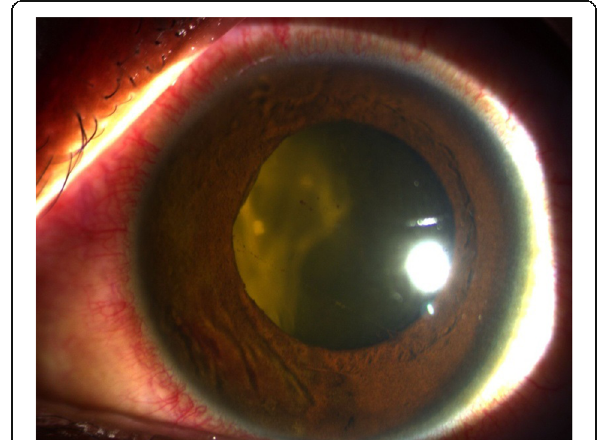
Fig. 4 On day 15 post-laser, seen are beginning nasal papillary synechiae, retrolental membranes, decreased anterior chamber reaction, homogeneous gray haze on indirect ophthalmoscopy, accompanied by BCVA of hand motion, light perception in all quadrants